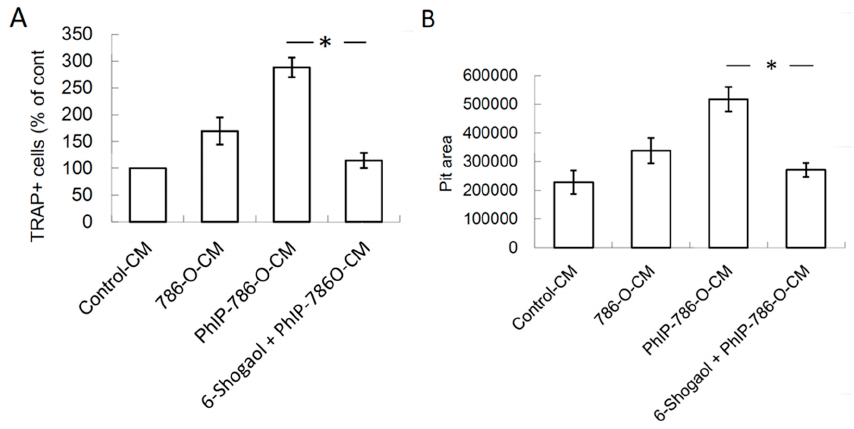
Figure 6. 6-Shogaol decreased the e ff ects of PhIP on in human 786-O renal cell carcinoma bone metastasis events. 786-O cells were pretreated with 6-shogaol for 1 h, and then incubated with 20 μ M PhIP for another 6 h. After replacing fresh medium and following a 24 h culture, the culture medium was collected. Subsequently, CD14 + monocytes were cultured with medium with 20% of collected medium containing M-CSF and RANKL for 14–21 days. ( A ) The e ff ect of 6-shogaol on osteoclastogenesis